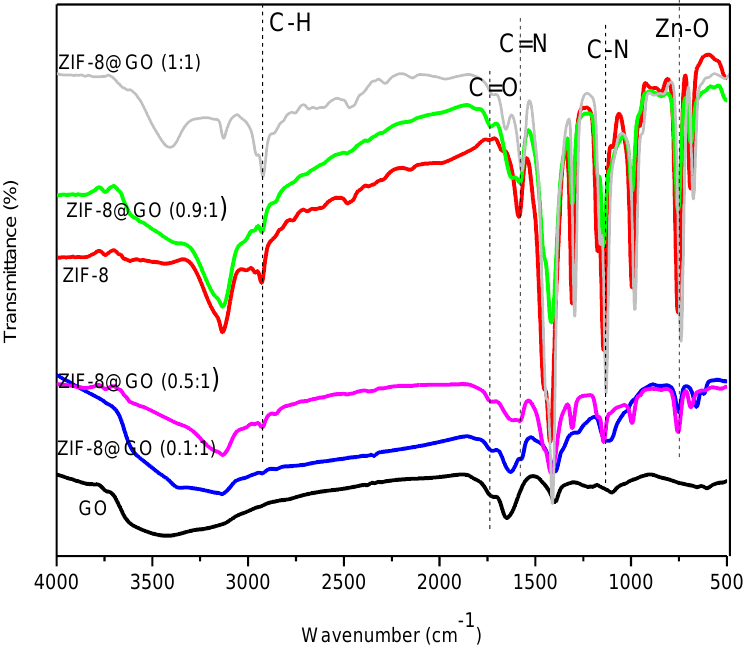
Figure 1. FTIR spectra recorded for GO, ZIF-8 and ZIF-8@GO composite.